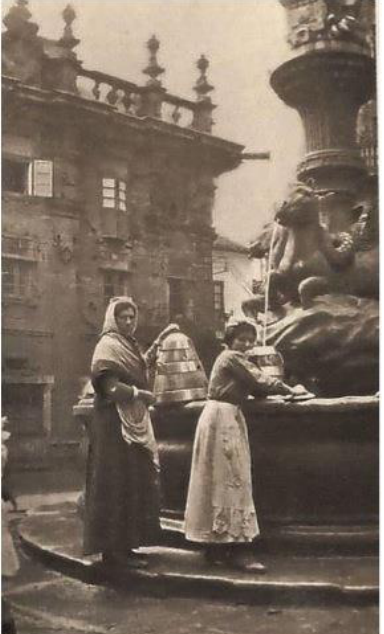
Unidentified photographer, The Fountain at Santiago , from Georgiana Goddard King, The Way of Saint James , vol.